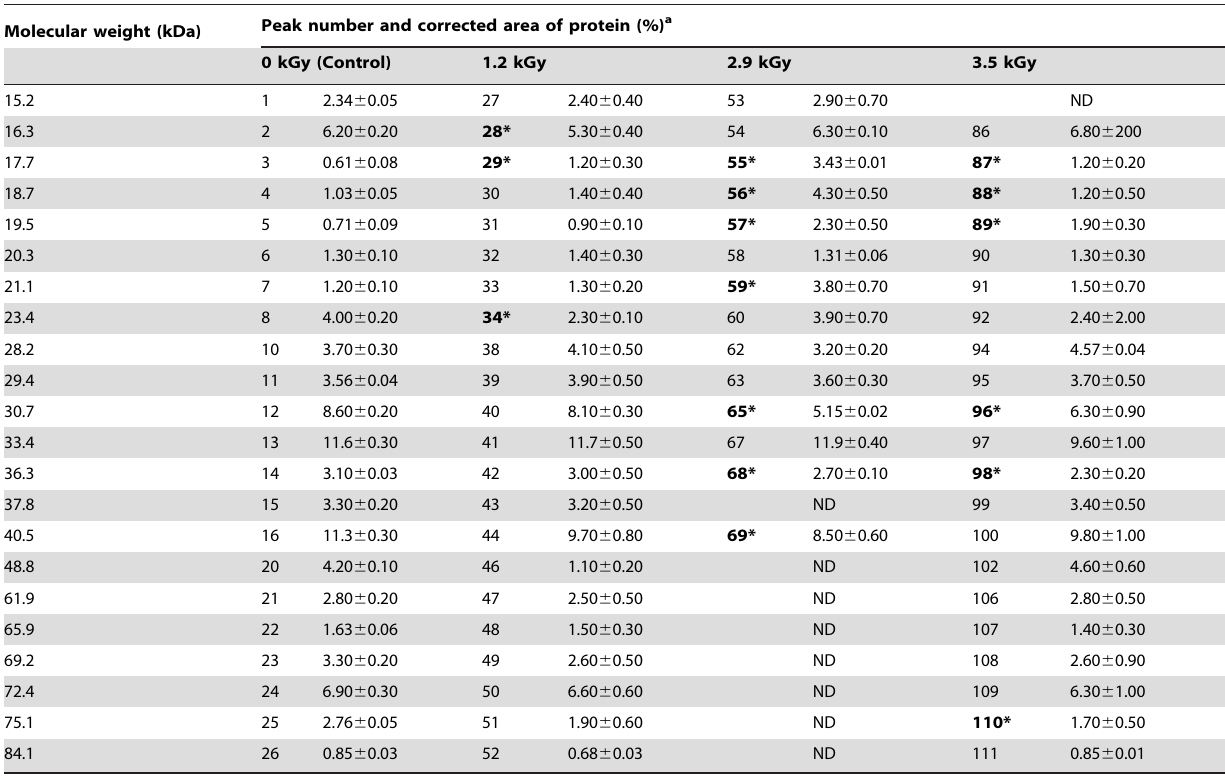
Table 2. Profiles of protein expression by Staphylococcus aureus at different doses of c -irradiation treatment.